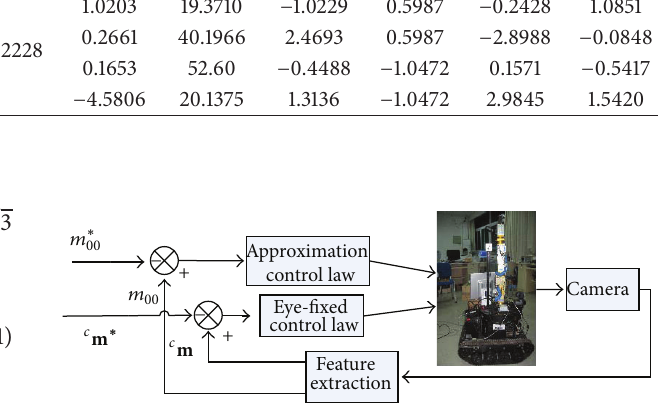
Figure 4: Scheme of eye-fixed